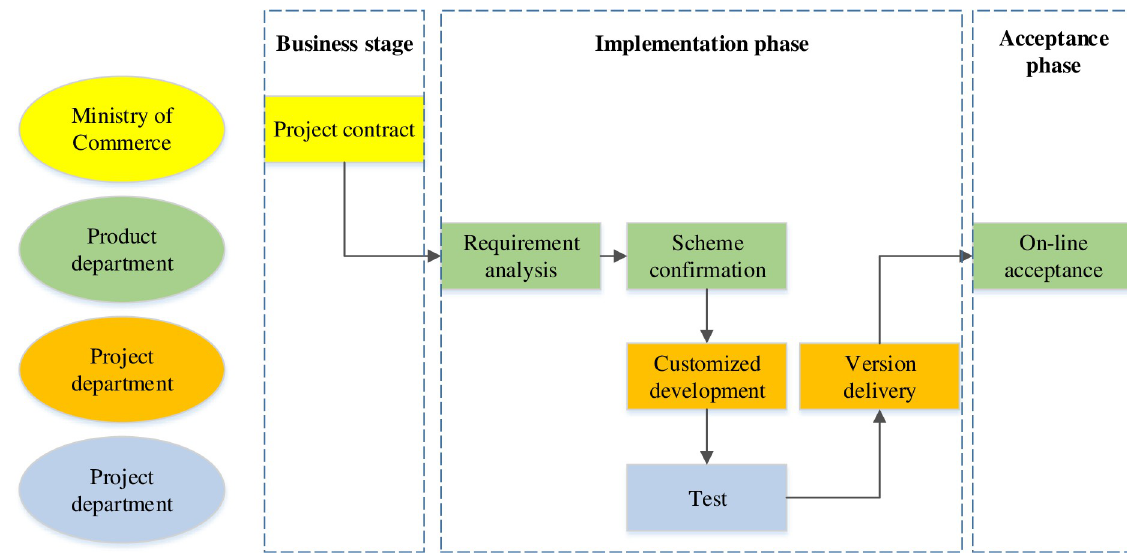
Fig 3. Optimized team business